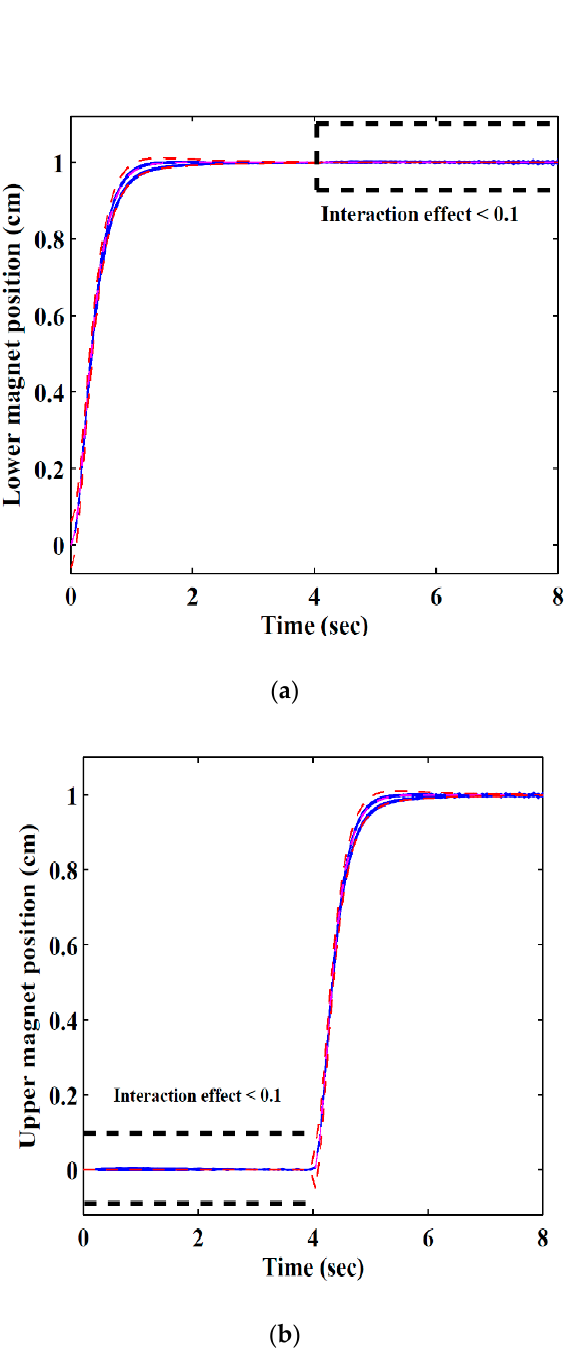
Figure 10. Interaction analysis: the closed loop (6561 plants) response of the designed control system; ( a ) channel-11 and ( b ) channel-22.